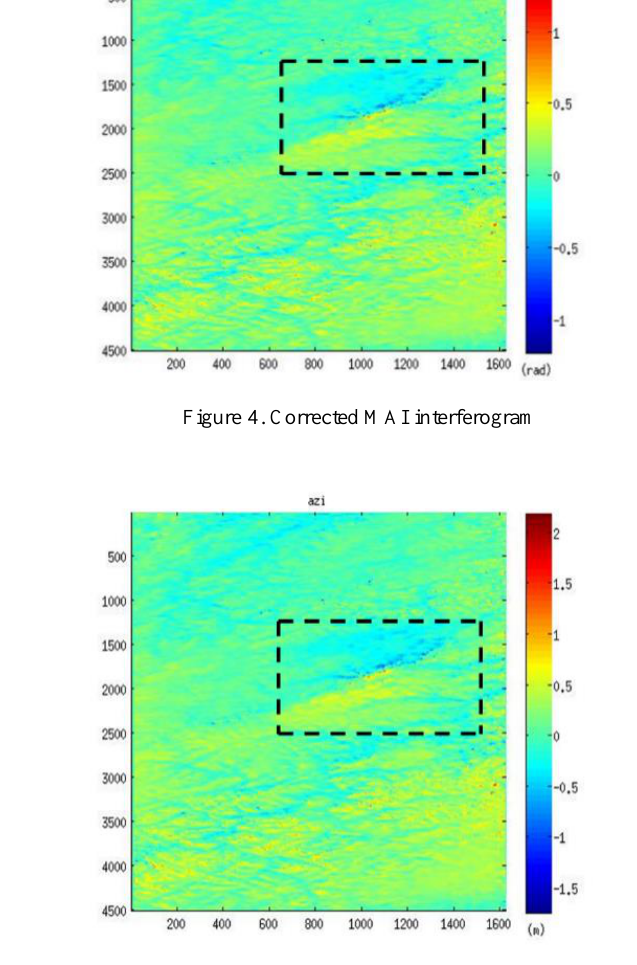
Figure 5. Co-seismic displacement field in the azimuth